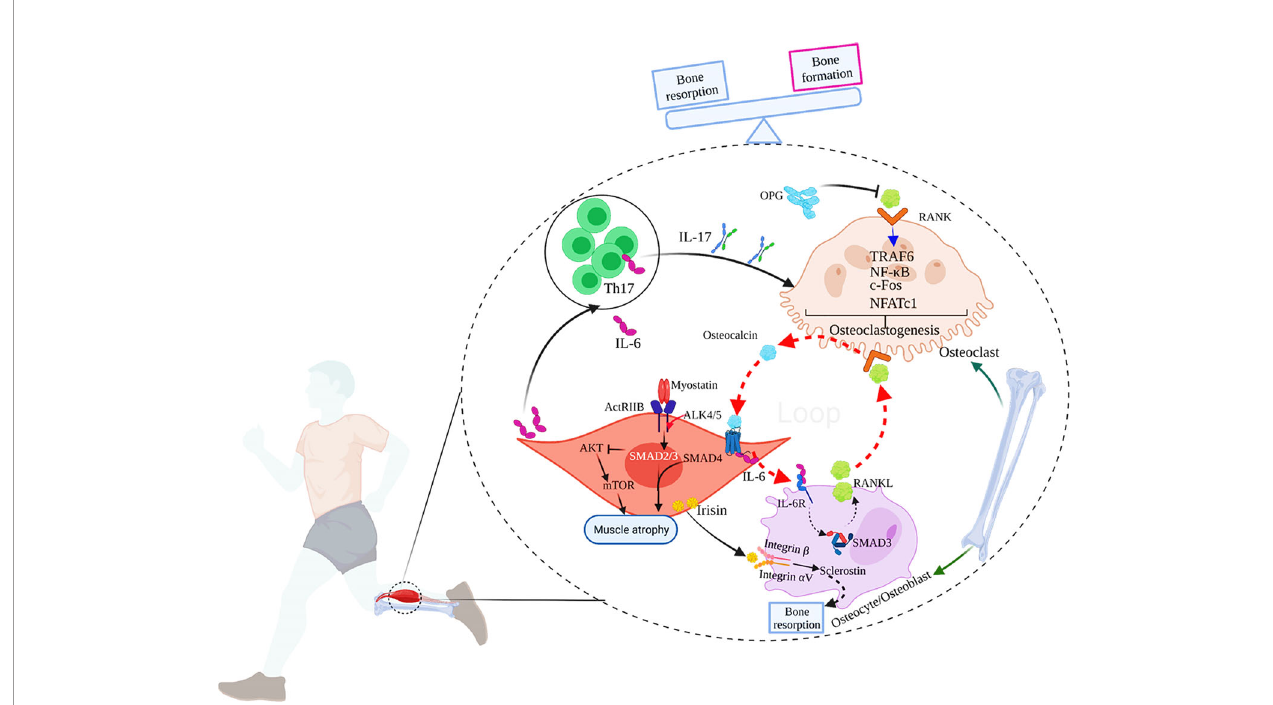
FIGURE 1 | The main mechanisms of muscle-bone crosstalk. 1) IL-17 secreted by Th17 cells induces RANKL expression in mice, which combines with RANK on the surface of osteoclasts to activate TRAF6 and c-Fos to induce osteoclastogenesis, and eventually, bone resorption occurs. OPG, the decoy receptor of RANKL, can prevent RANKL from activating RANK in the extracellular environment, thereby inhibiting osteoclast formation and bone loss; 2) During exercise, the muscle-derived IL-6 (mIL-6) acts on the IL-6 receptor on the surface of osteoblasts and increases the production of RANKL, subsequently promoting osteoclast differentiation and the secretion of bioactive osteocalcin through RANKL/RANK pathway in osteoclasts. In turn, osteocalcin also enhances the production of mIL-6 during exercise. Thus, a feed-forward loop between muscle and bone favors exercise adaptations. 3) Myostatin signals through ActRIIB, which forms a heterodimer with ALK 4/5. The intracellular ALK4/5 phosphorylates SMAD2 and SMAD3, and then forms a complex with SMAD4. The complex translocates to the nucleus to regulate the transcription of genes involved in the proliferation and differentiation of skeletal muscle precursor cells. The activation of SMAD2 and 3 by myostatin also inhibits the Akt/mTOR pathway in response to pro-growth signals, and therefore, suppresses protein synthesis. Ultimately, myostatin contributes to muscle atrophy. 4) Irisin produced by skeletal muscles during exercise acts on integrin a V/ b on the surface of osteocytes to promote sclerostin production, leading to bone resorption. 5) IL-6 can also promote the generation of